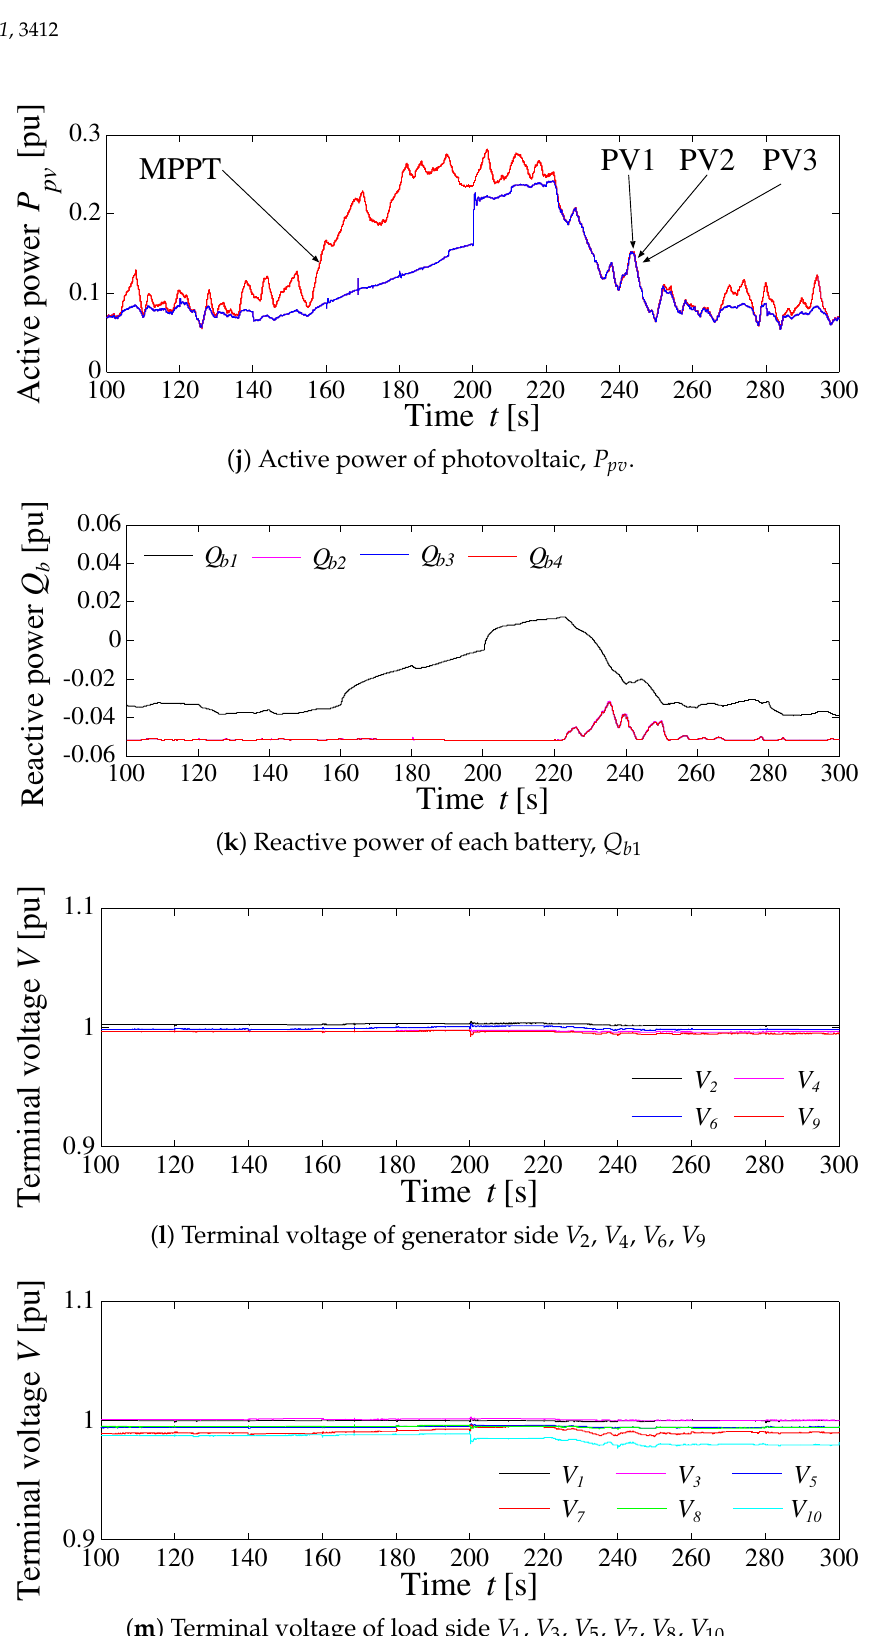
Figure 18. Simulation result (with battery, suppression of renewable energy sources, and demand